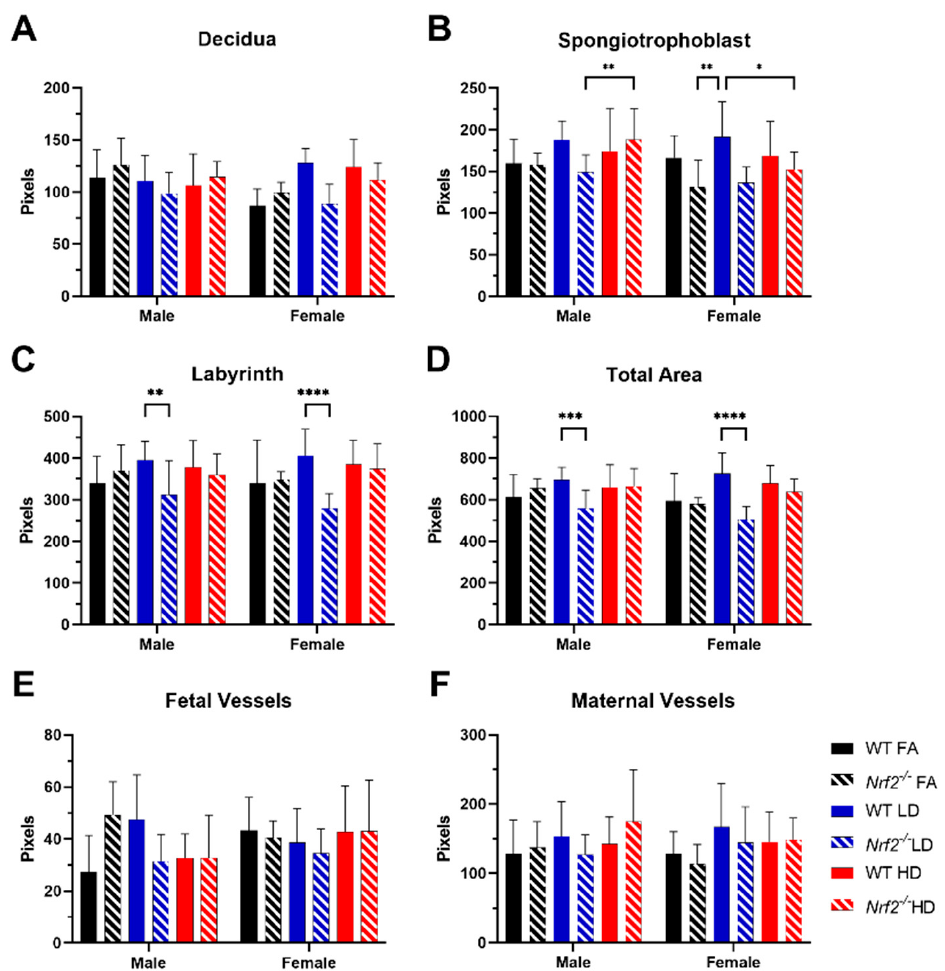
Figure 4. Placental Morphology. Comparisons of WT and Nrf2 − / − placenta from pregnant mice exposed to filtered air (FA) control (black), low dose (LD) (blue), or high dose (HD) (red). Placenta area of the decidua ( A ), spongiotrophoblast ( B ), labyrinth zones ( C ) and total area ( D ) were quantified for each H&E-stained section. Fetal vessels ( E ) and maternal vessels (i.e., lacunae) ( F ) were measured in labyrinth zone images. Error bars represent SD. Data analyzed using one-way ANOVA with Tukey’s multiple comparison test. (* p < 0.05; ** p < 0.01; *** p < 0.001; **** p < 0.001). Sample sizes shown in Figures 2 and 3.